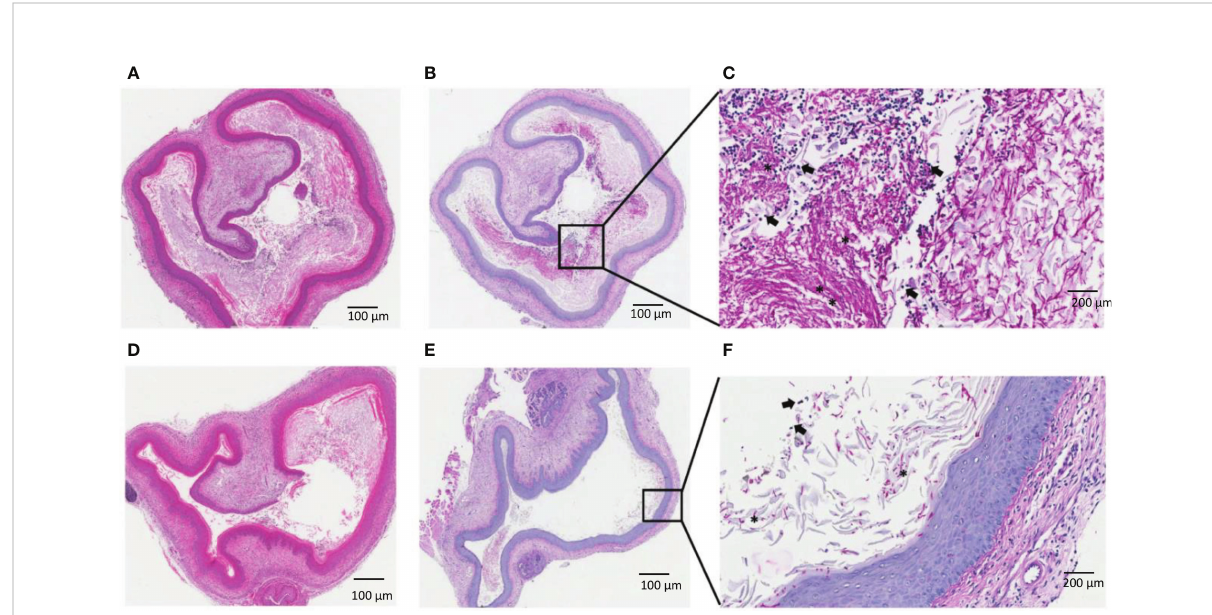
FIGURE 3 Histological evaluation of vaginal candidiasis following treatment with Q-GRFT. CBA/J mice were infected with C. albicans vaginally. 5 days later, topical treatment was initiated with Q-GRFT gel (vaginally) twice daily for 7 days. Post-treatment (Day 12) tissue histology is presented. (A) Representative H&E staining of mice vaginal tissue in the infected, untreated group. (B, C) PAS staining of infected, untreated mice. Note the predominance offungal growth/ burden in the vaginal lumen. (D) Representative H&E staining of vagina tissues from Q-GRFT treated mice. (E, F) , PAS staining of vaginal tissue from Q- GRFT-treated mice. (*) represents fungal hyphae and black arrows depict neutrophils in the